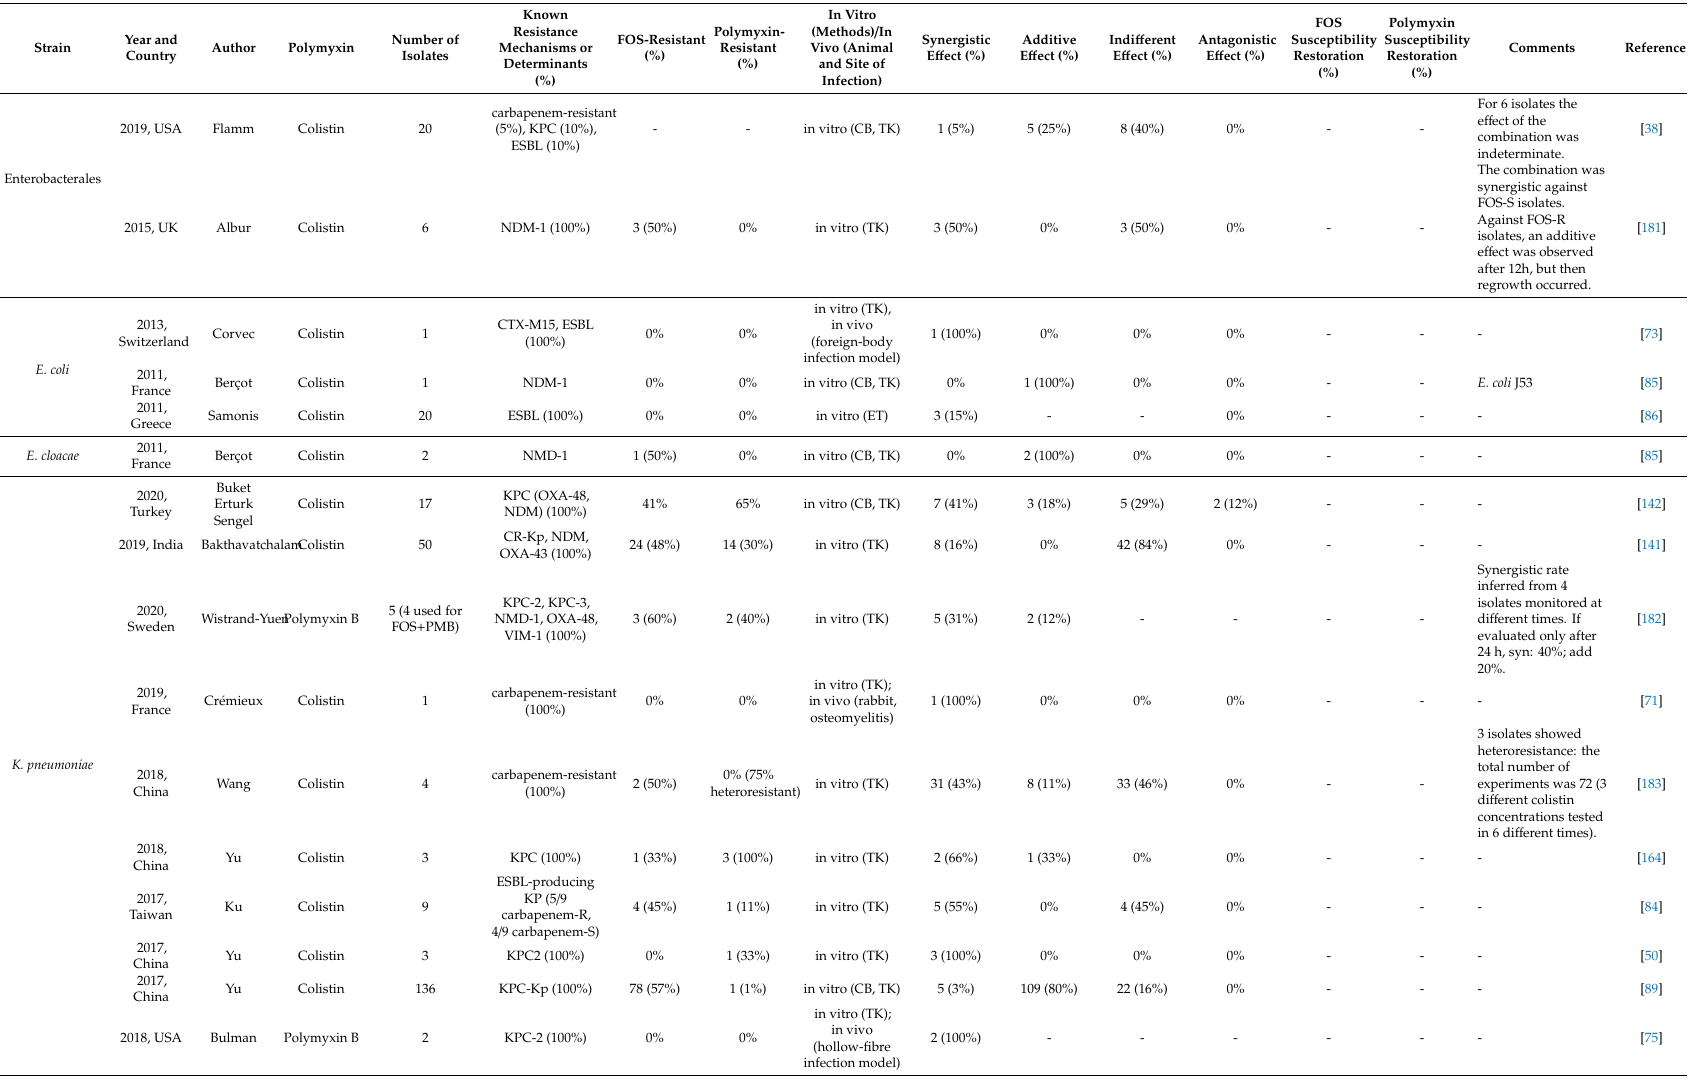
Table 10. Studies on combination between fosfomycin and polymyxins. CB: checkerboard assay; TK: time–kill assay; ET: E-test.